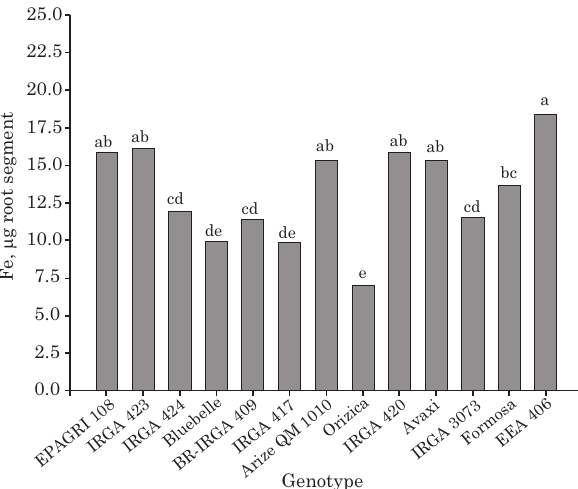
Figure 6. Total iron (sum of three segments) on the surface of adventitious roots of rice genotypes after exposure to a solution of an Albaqualf soil with pH = 6.0 and 80 mg L -1 of Fe. Lowercase letters compare genotypes by the LSD test (p